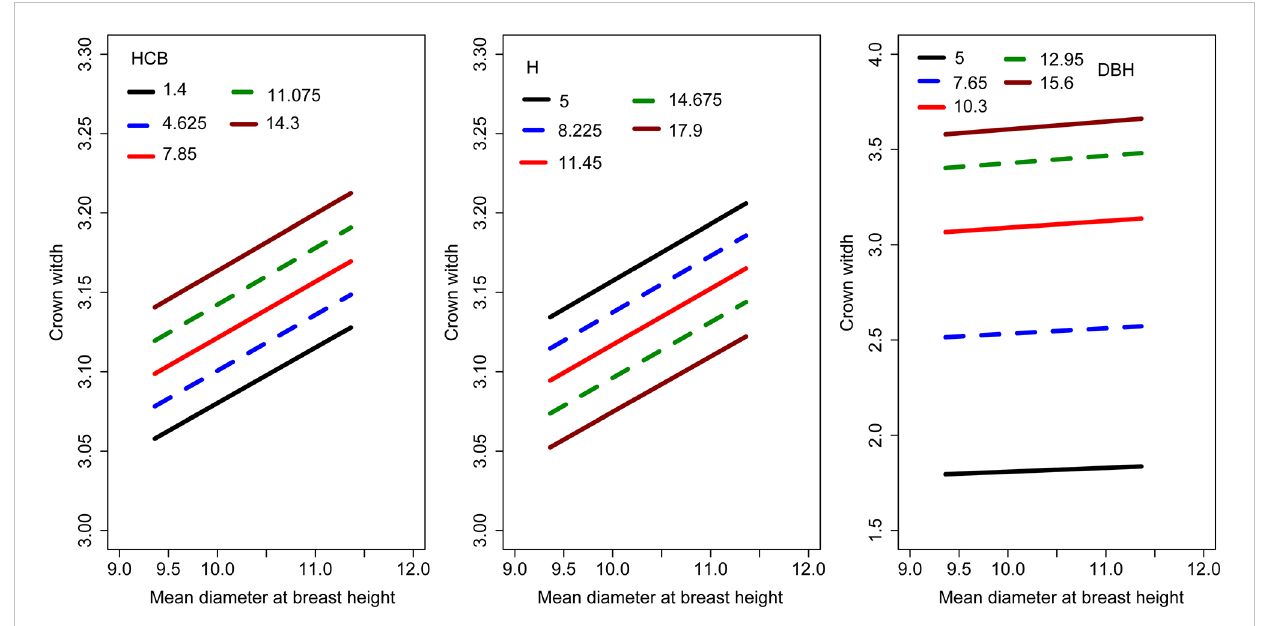
FIGURE 2 Effects of H, HCB and DBH on the CW. The curves were produced using the logistic model, i.e., Eq.